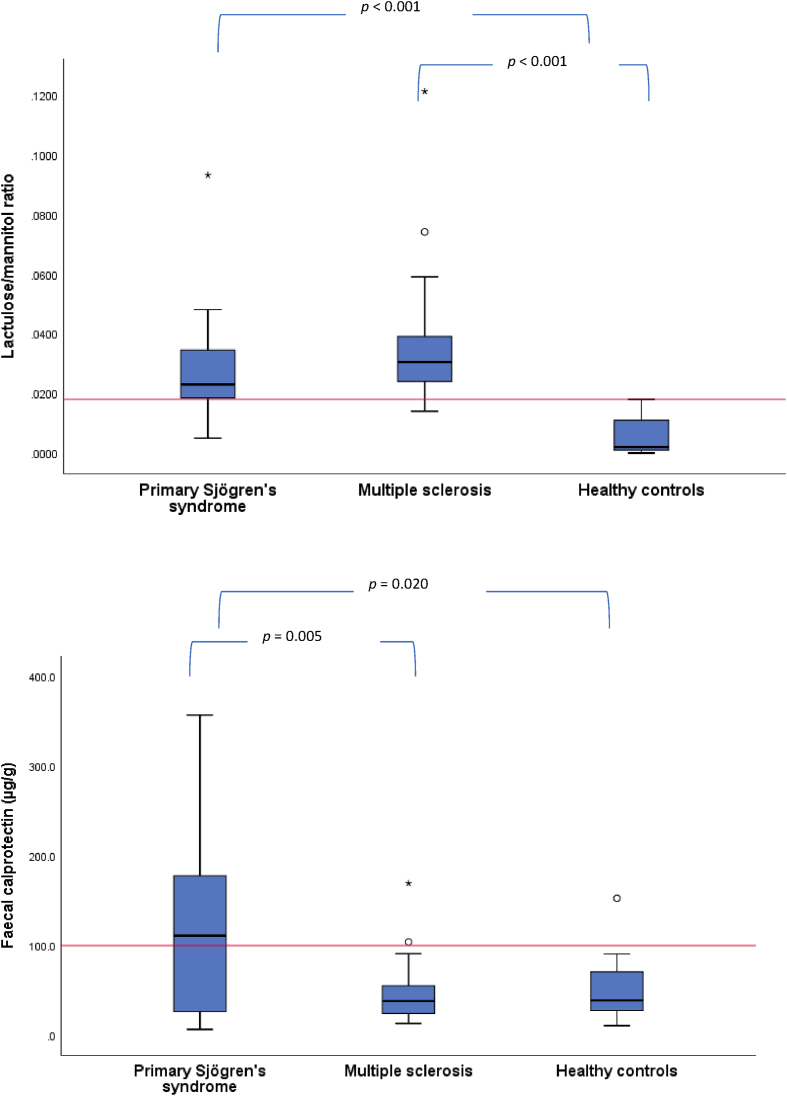
(A) Lactulose/mannitol urine concentrations ratio serving as a measure of intestinal permeability. The red line indicates the cut off. (B) Faecal calprotectin serving as a measure of intestinal inflammation. The red line indicates the level of 100 ​μg/g clinically used as a marker of intestinal inflammation in inflammatory bowel disease. Boxes represent values between quartiles 1 and 3, and a thick line indicates the median. Whiskers show the max and min values located above the top or below the bottom of the box, respectively, within a 1.5 interquartile distance. Circles denote outliers values located outside a 1.5 interquartile distance, and stars denote outliers located outside a 3 interquartile distance. Two extreme primary Sjögren’s syndrome outliers at 1113 and 2037 ​μg/g are not shown, but are included in the calculation of the box and whiskers. (For interpretation of the references to colour in this figure legend, the reader is referred to the Web version of this article.)